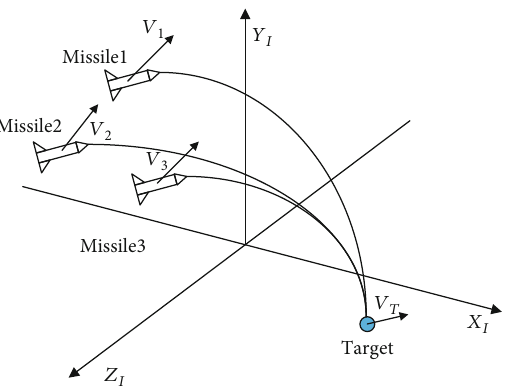
Figure 1: Engagement geometry in a 3-D plane for a single